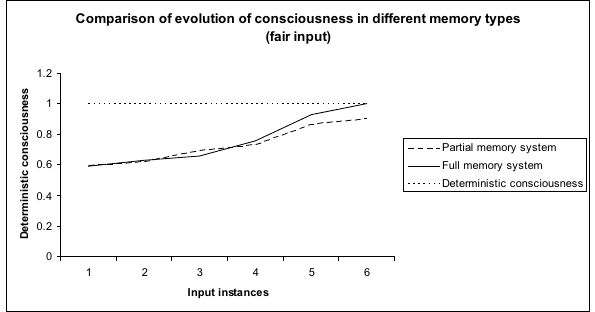
Fig. 32. Comparison of deterministic consciousness with memory (fair input).